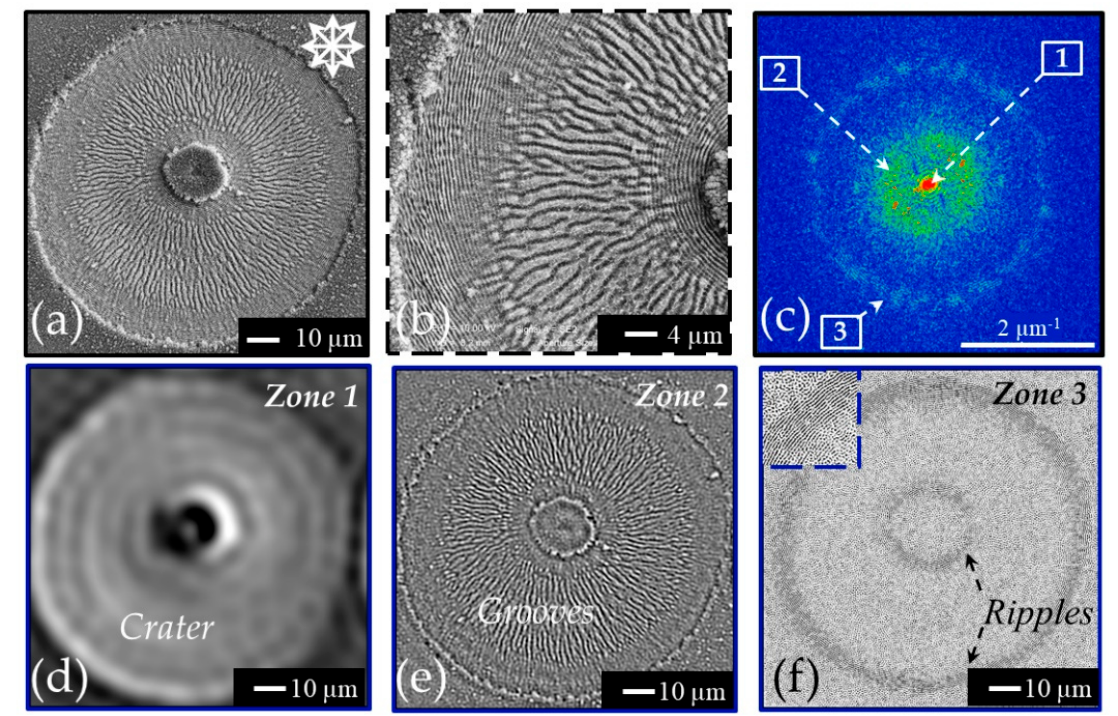
Figure 4. Panel ( a ) reports the SEM image of the sample surface after irradiation with a sequence of N = 100 pulses of a radially polarized vector vortex beam at 800 nm with pulse duration of ≈ 35 fs and energy of E ≈ 30 μ J. The zoomed view in panel ( b ) provides a clearer sight of the radial grooves and azimuthal ripples generated on the surface. Panel ( c ) shows a 2D-FFT map obtained from the SEM image of panel ( a ) evidencing three different zones. Panel ( d – f ) display the 2D-IFFT of each one of the three different zones separately as indicated in the top-right corner of each image depicting crater, grooves, and ripples, respectively. The dashed box in the upper-left corner of panel ( f ) shows a magnified view of the ripples.